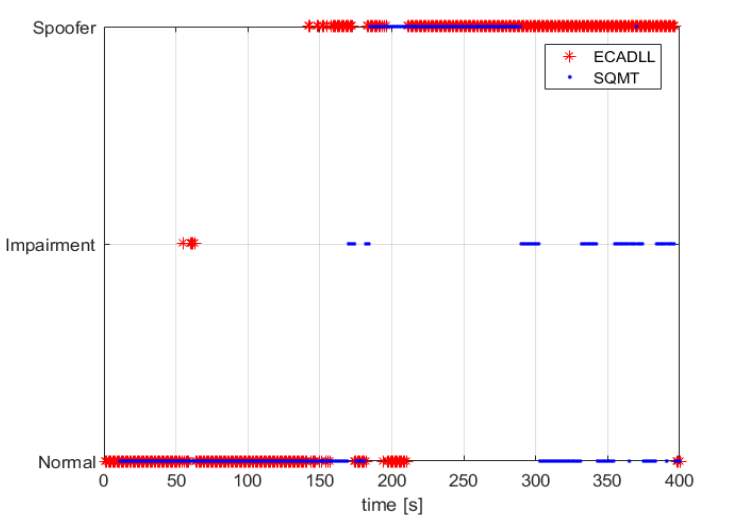
Figure 17. Comparison of the impairment detection using GPS Satellite Number 15 for the dynamic dataset, TEXBAT ds6. In red, the decision made by ECADLL is shown and in blue, the one using